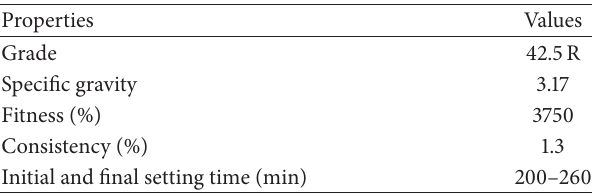
Table 3: Engineering properties of sandy soils.